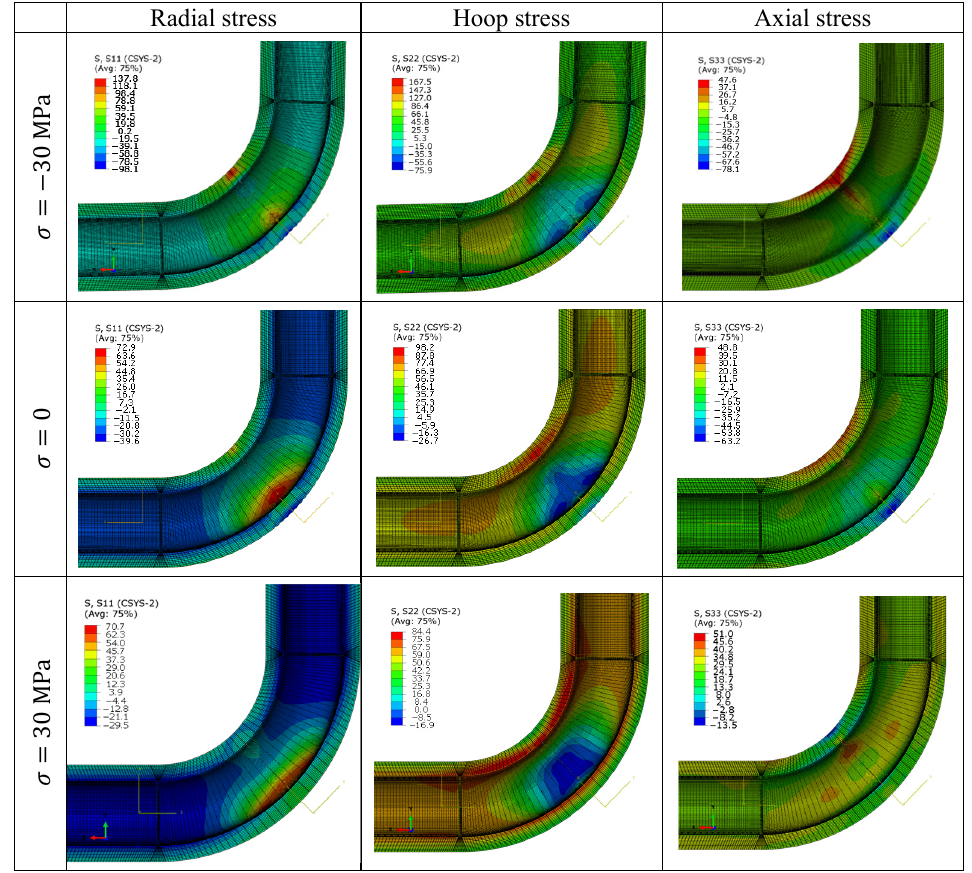
Figure 3. Stress distribution after creep for 5000 h under various axial structural induced